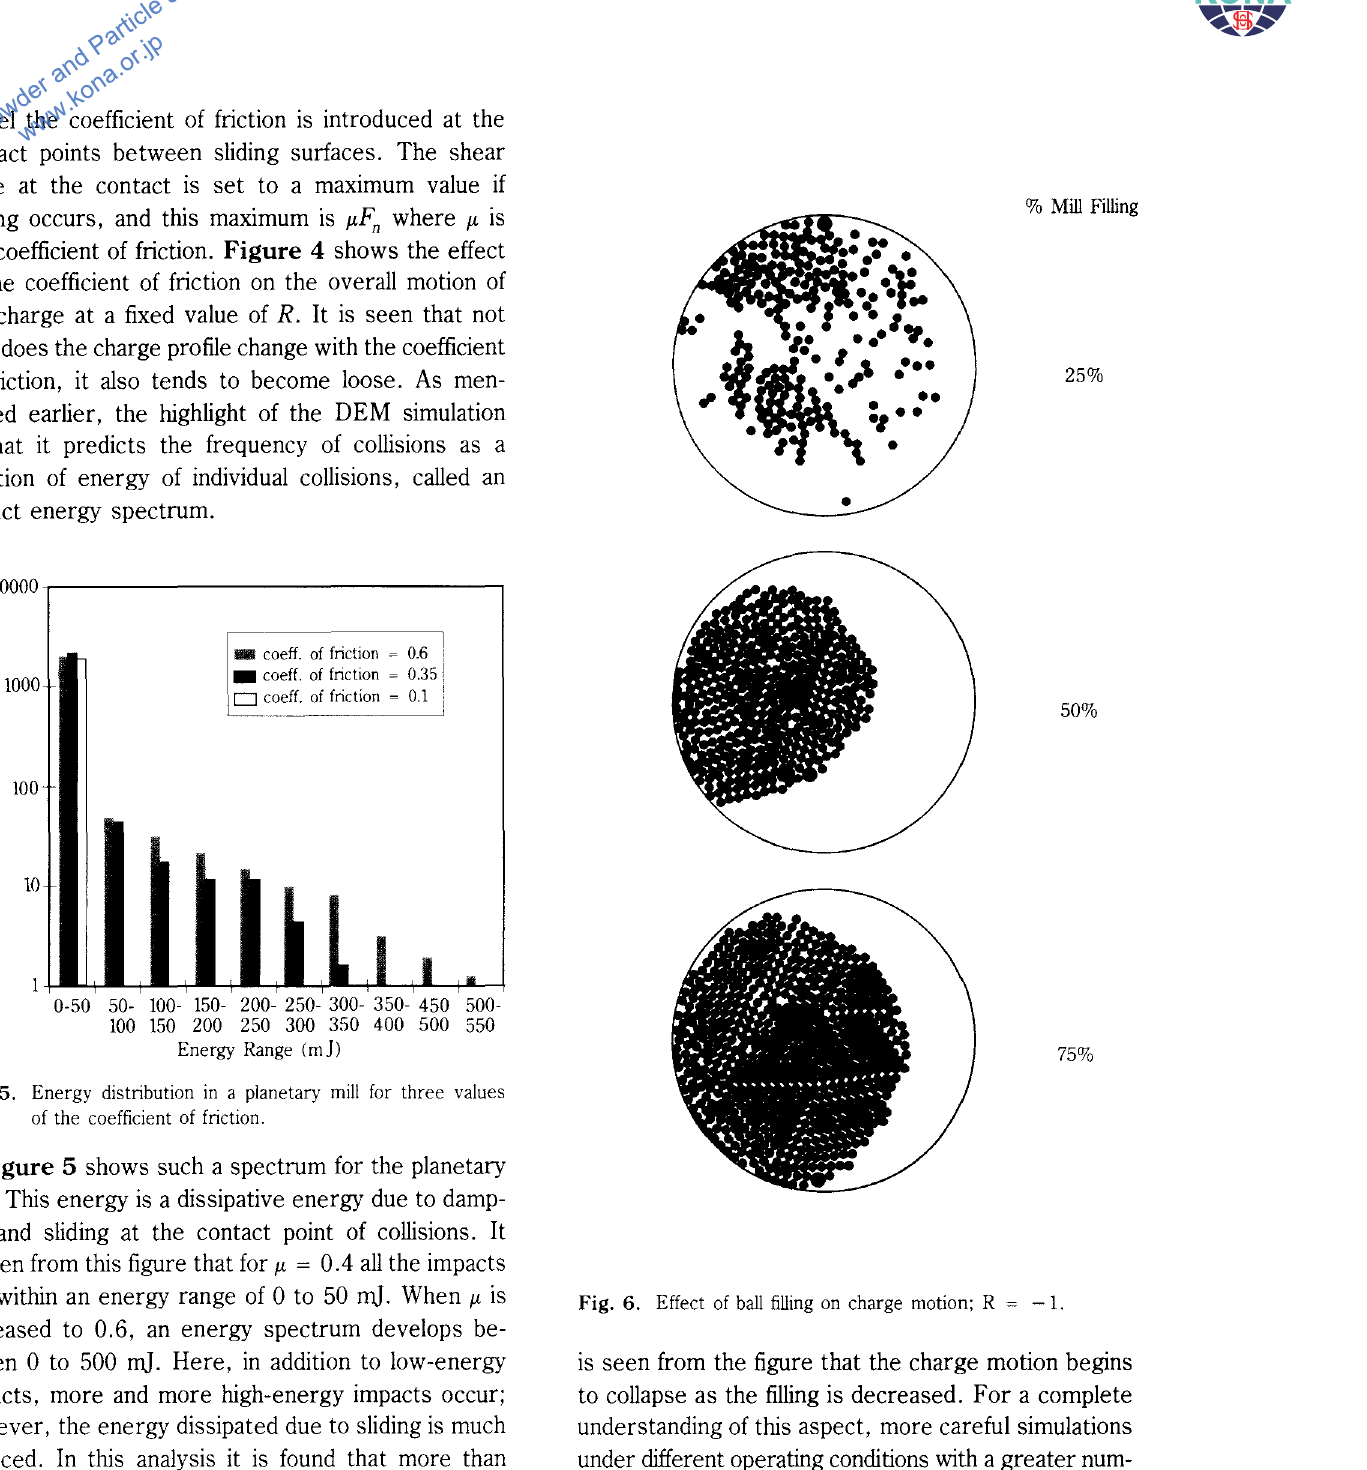
Fig. 5. Energy distribution in a planetary mill for three values of the coefficient of friction.